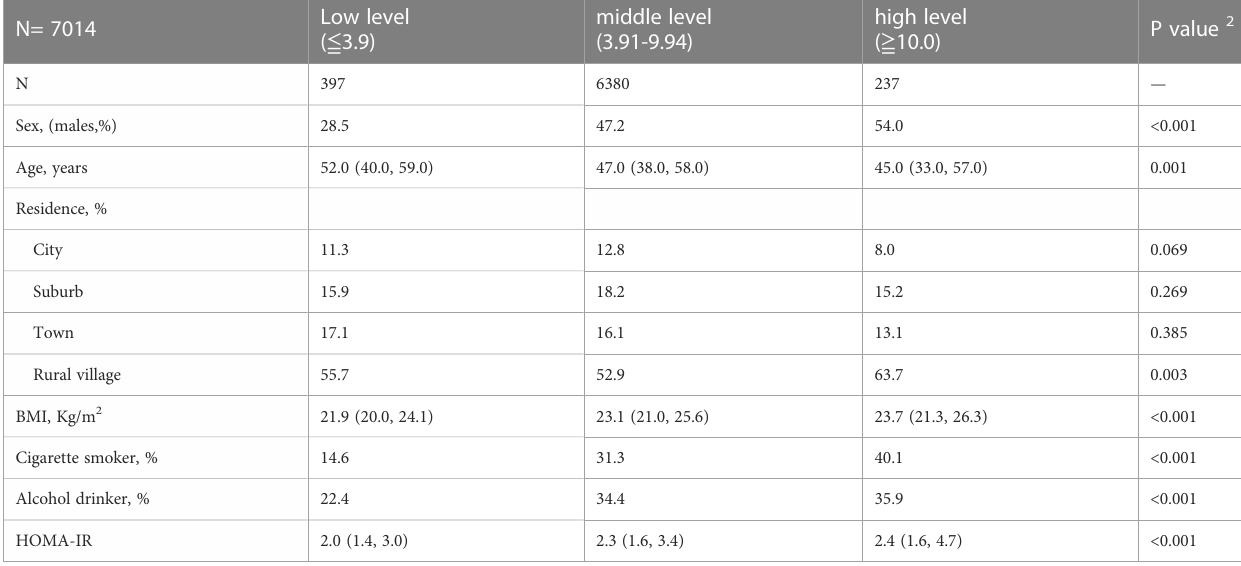
TABLE 1 Participants ’ characteristics according to WBC counts category